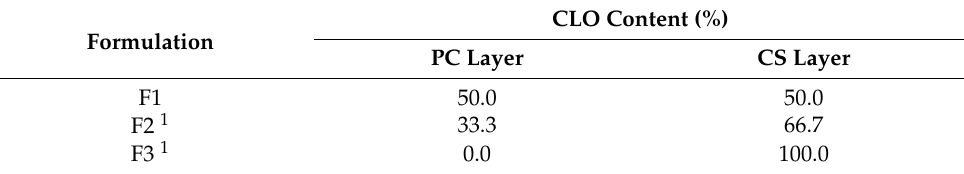
Table 1. Percentage distribution of CLO in the films